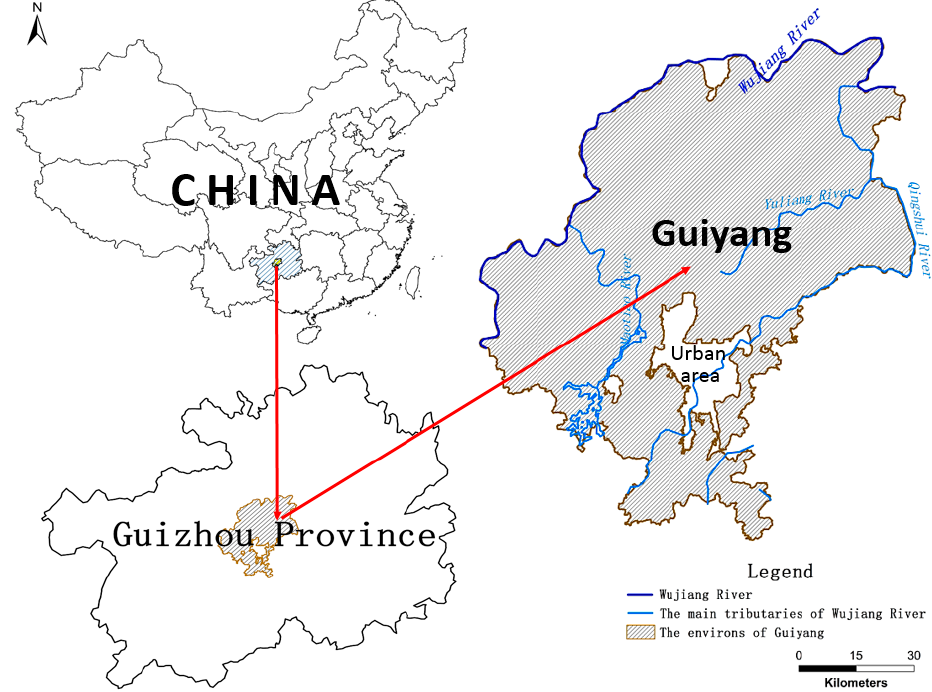
Figure 2. Location of Guiyang, Southwest China.